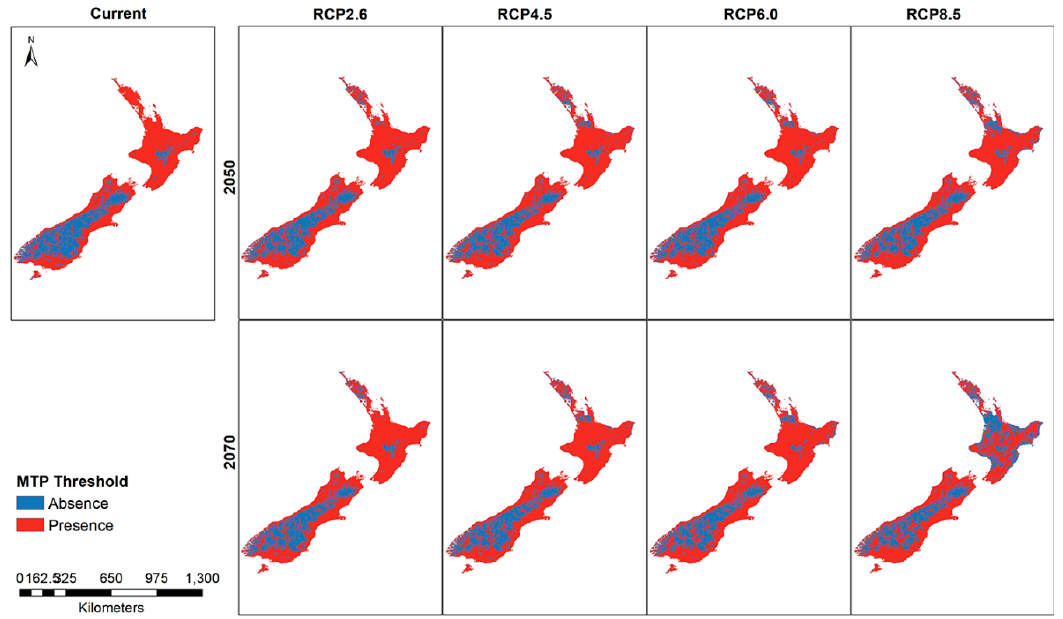
Figure 6. New Zealand presence and absence threshold for the Mexican daisy under different climate scenarios and years.